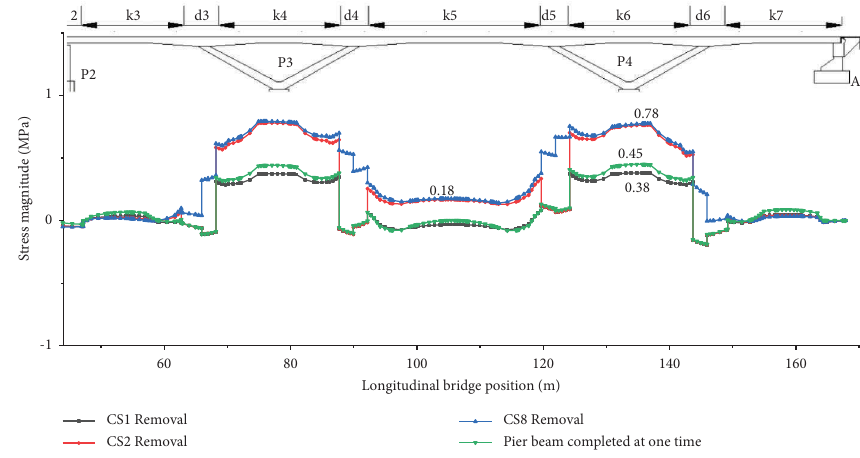
Figure 10: Stresses at lower edges of bridge deck